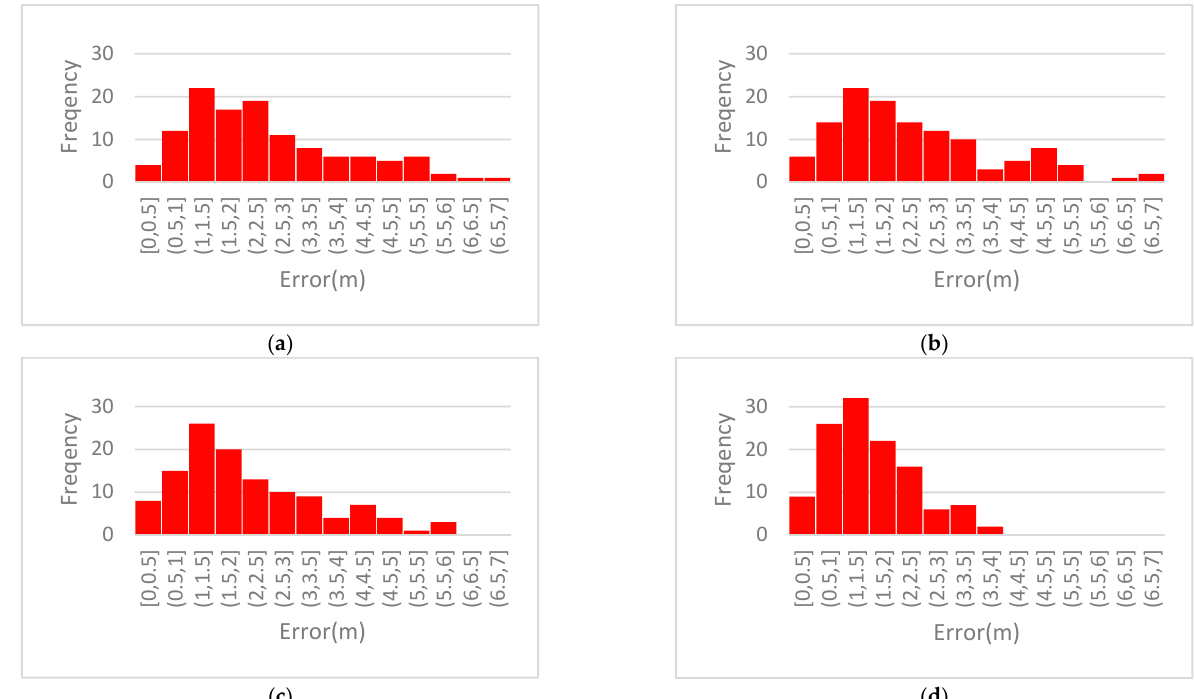
Figure 11. Error distribution frequencies: ( a ) Error frequency of A; ( b ) Error frequency of B; ( c ) Error frequency of C; ( d ) Error frequency of method in this paper.